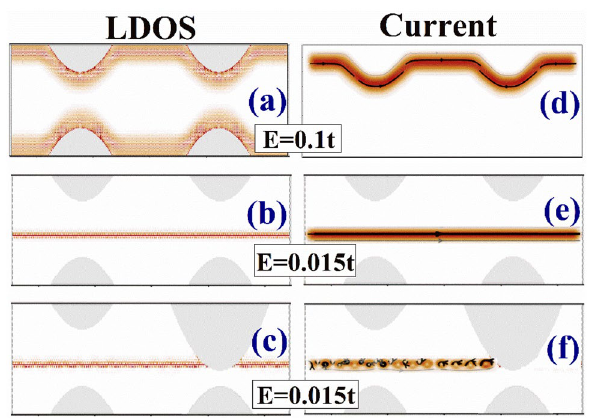
Figure 5. ( a ) and ( d ) show the LDOS and current of the device respectively for E = 0.1t. ( b ) and ( e ) show the LDOS and current of the device respectively for E = 0.015t, and the shape and the size of the device are the same as that in Fig. 1( a ). ( c ) and ( f ) show the LDOS and current of the device respectively for E = 0.015t, but the sizes of the constrictions are changed to W 1 = 15 nm and W 2 = 5 nm. The magnetic flux and electric field are φ = 0.0015 and eE y = 0.001 t /nm